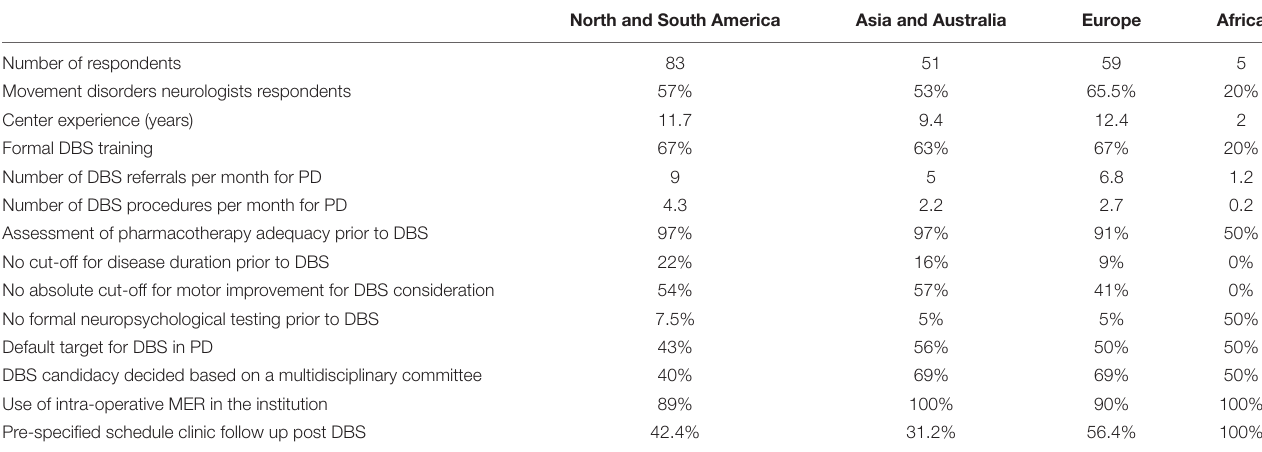
FIGURE 5 | Deep Brain Stimulation targets reported to be utilized for the management of Parkinson’s disease. TABLE 1 | Regional variability in Deep Brain Stimulation practices in Parkinson’s